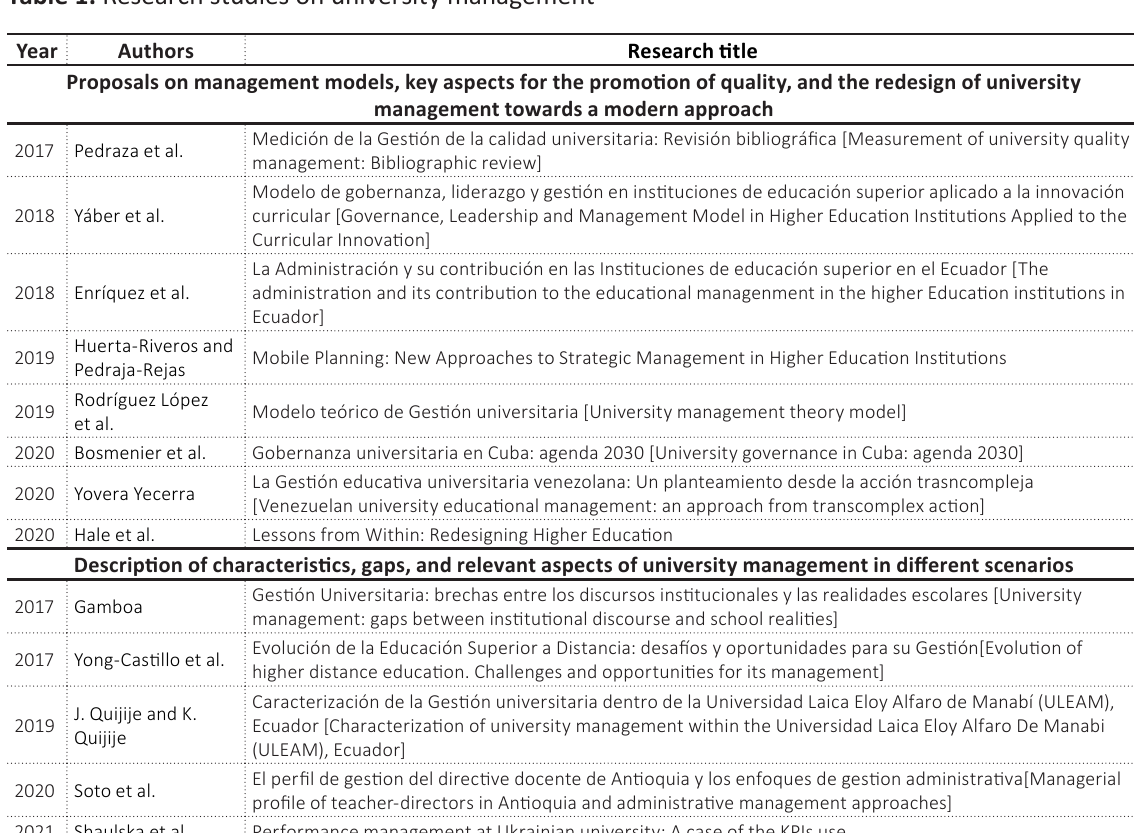
Table 1. Research studies on university